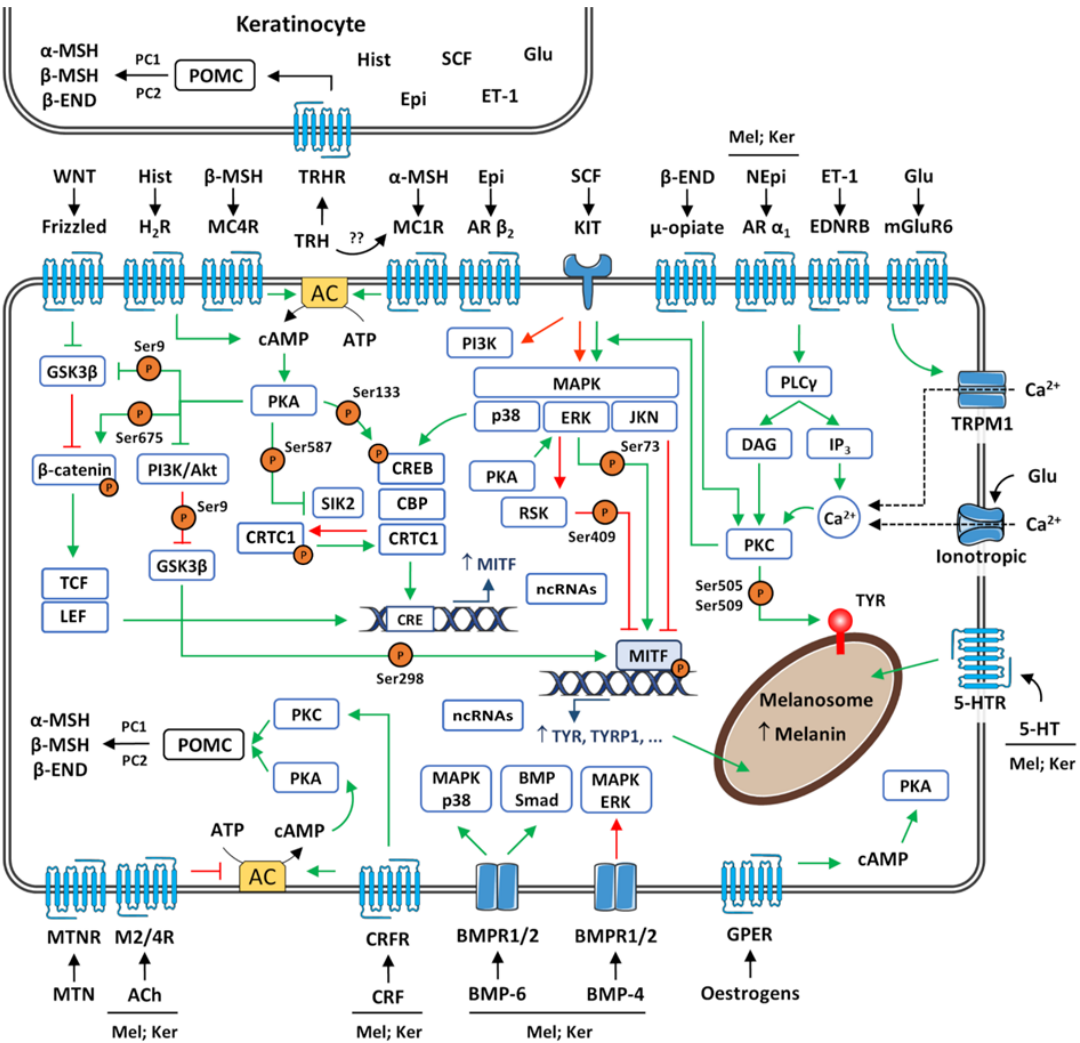
Figure 8. Major molecular pathways involved in the regulation of melanin synthesis in melanocytes. Green lines denote positive regulation of melanogenesis. Red lines refer to negative regulation of melanogenesis. α/β-MSH: α/β-melanocyte-stimulating hormone; β-END: β-endorphin; 5-HT(R):